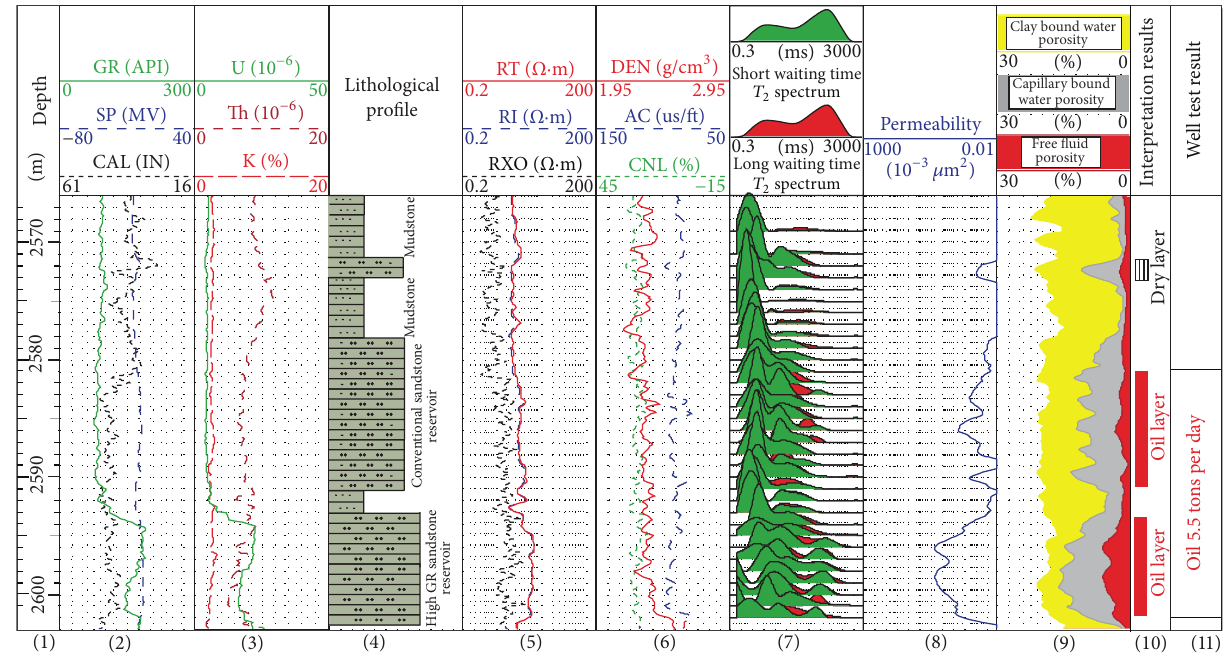
Figure 5: Conventional logs and NMR log responses of a well in study